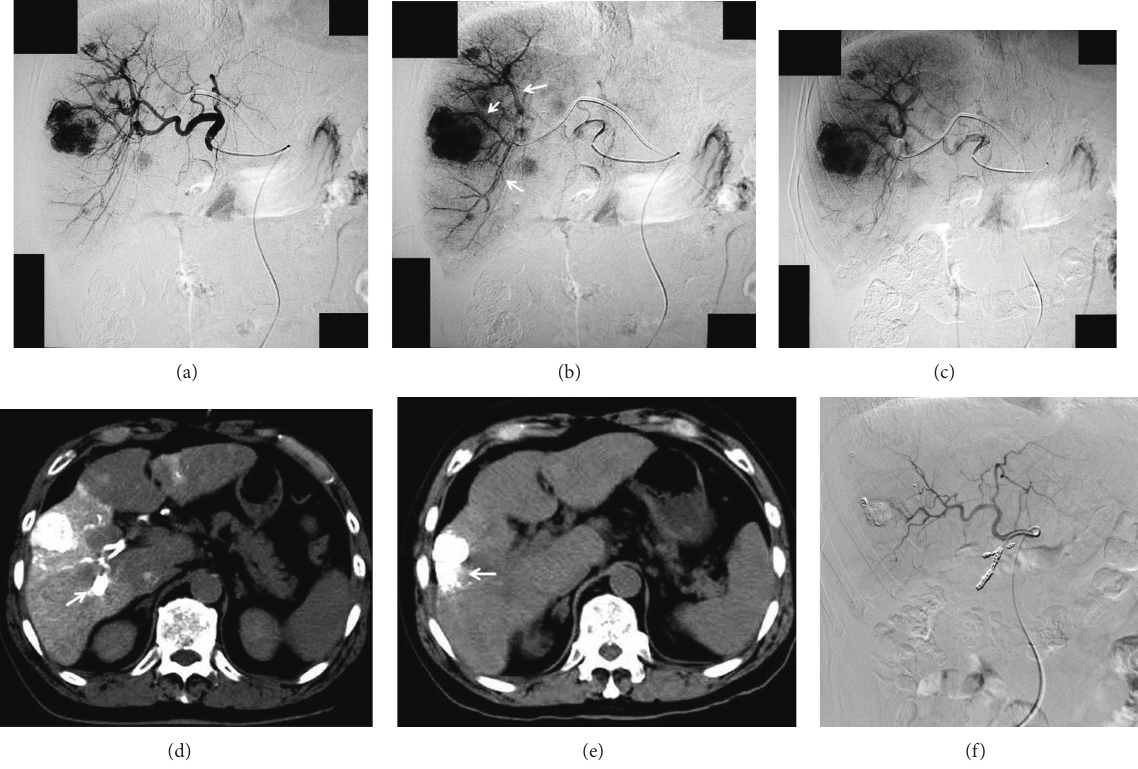
Figure4:MultipleHCCswithsignificantarterioportalshuntsina58-year-oldman.Properhepaticarteriography((a):earlyarterialphase,(b): late arterial phase) reveals multiple HCCs with significant arterioportal vein shunts ((b), arrows). (c) indicates proper hepatic arteriography under balloon occlusion of the anterior segmental portal vein. CT during right hepatic arteriography before TACE shows a well-enhanced HCC in the S5. Arrow of (d) indicates a balloon. Precontrast CT one month after TACE-PVO demonstrated a dense lipiodol deposit HCC (e). Lipiodol retains in both HCC and surrounding liver parenchyma ((e), arrow). Common hepatic arteriography 12 months after TACE-PVO reveals that arterioportal shunts and hypervascular tumors are no longer evident (f). The patient first received 2 sessions of conventional TACE for residual HCCs. Reservoir placement was performed 9 months after TACE-PVO. The patient is alive for 4 years after TACE-PVO.